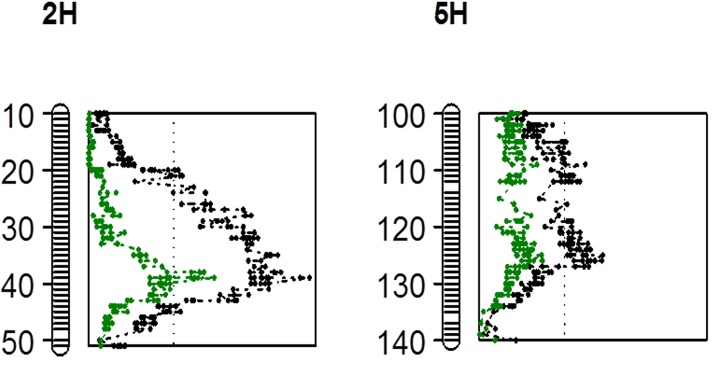
Comparison of LOD values of QTL associated with SalinityD tolerance on chromosome 2H (A) and 5H (B) before and after flowering time was used as a covariate.Map distances in centiMorgan (cM) shown to the left. The vertical dotted line indicates the significance threshold of LOD 3.0. Black: LOD value range of original QTL; Green: new LOD value range of QTL when trait of flowering time was used as a covariate.